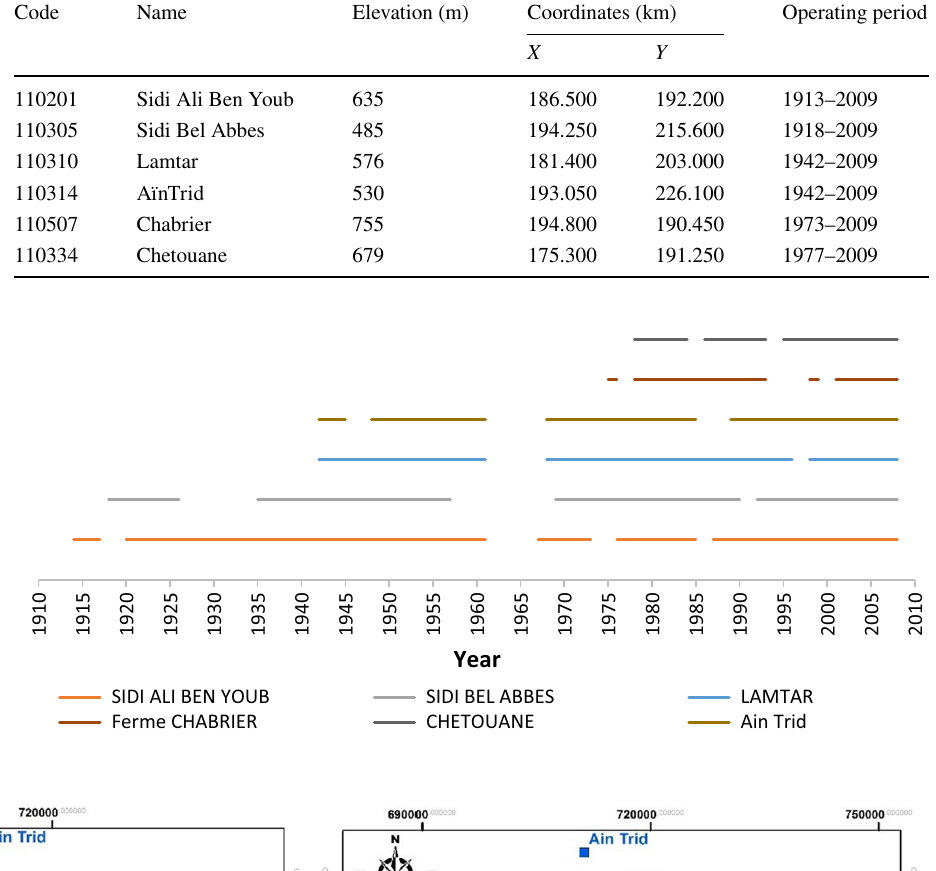
Table 1 Rainfall station